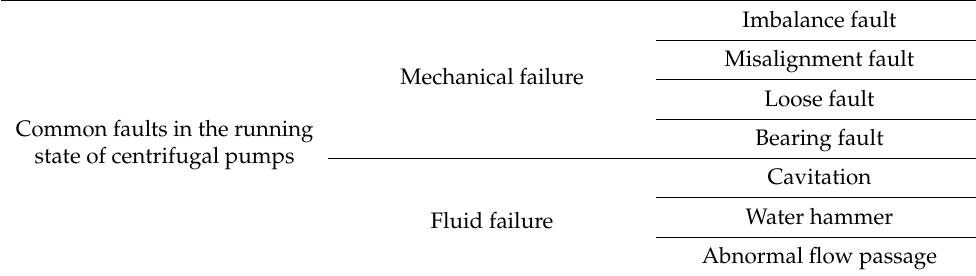
Table 1. The types of faults that often occur when centrifugal pumps are running.